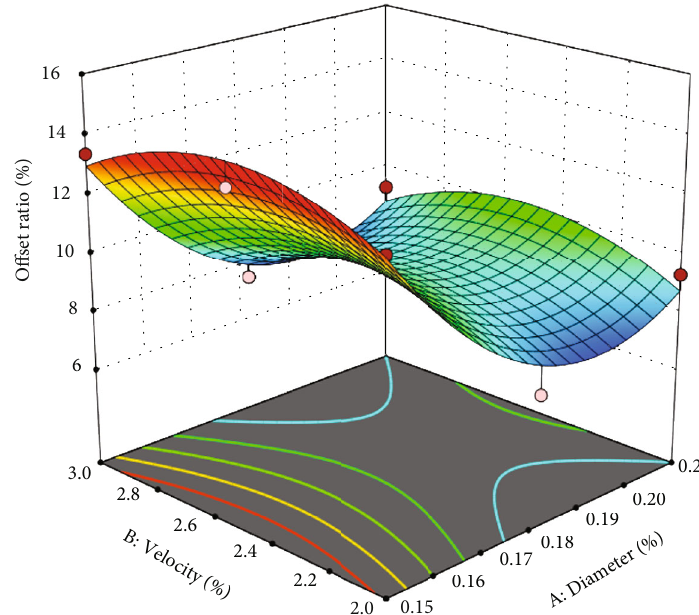
Figure 13: Response surface.